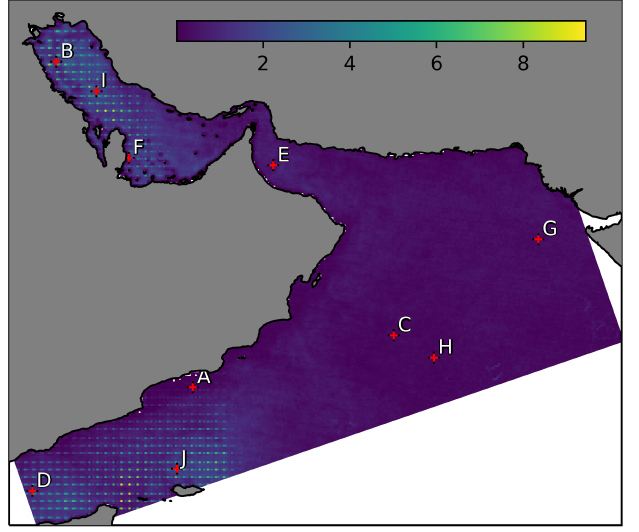
Figure 2. Domain of the operational system, showing the locations where the covariance functions were computed. The background colours show the density of innovations as the mean number of innovations per day on each grid